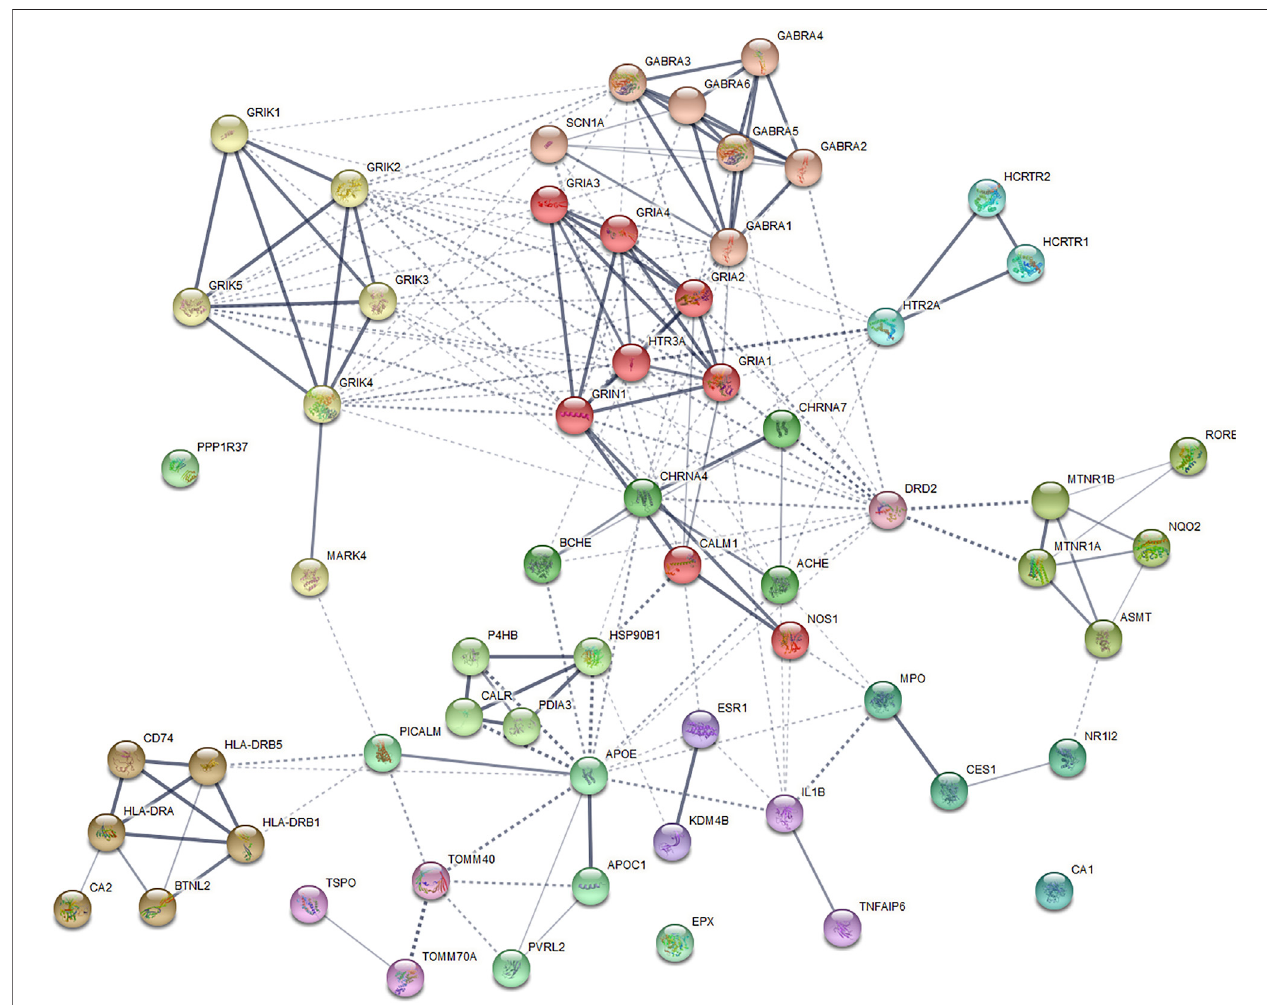
FIGURE 5 | Protein – protein interaction subnetworks identi fi ed by the Markov cluster algorithm. The protein-coding genes shared between AD and insomnia and the FDA-approved AD and insomnia drug target genes were used to construct a functional similarity network of genes (see the Methods section). Nodes are colored to show association. The thickness of lines connecting nodes indicates the strength of the association between